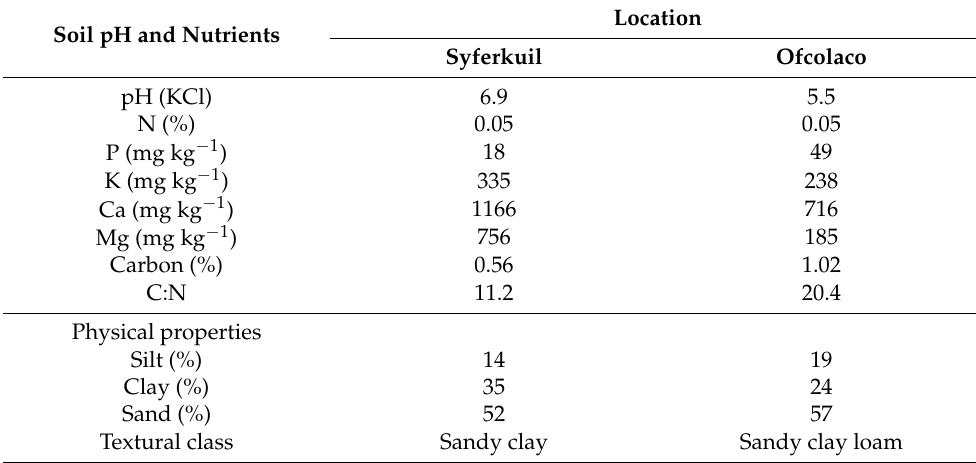
Table 2. Soil chemical and physical properties at Syferkuil and Ofcolaco.